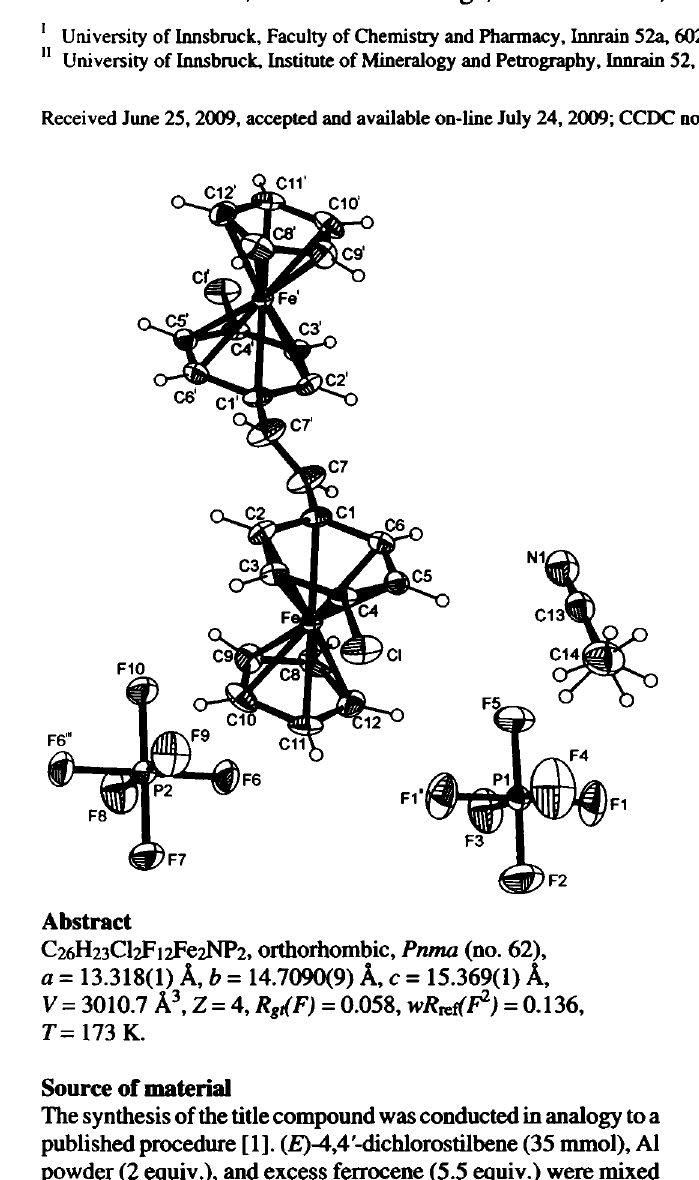
Table 2. Atomic coordinates and displacement parameters (in Â 2